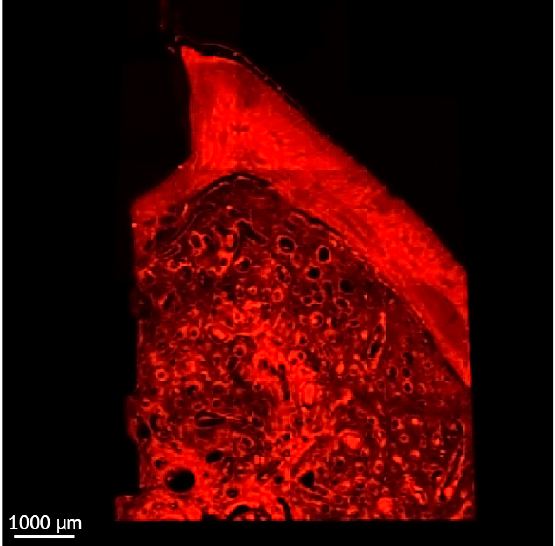
Figure 4. Soft tissue and bone in a thick section of a non-ligated implant. Bone is in contact with the implant surface. Soft tissue is in contact with the healing abutment. (implant #2, oral aspect; bar, 1000 µm).